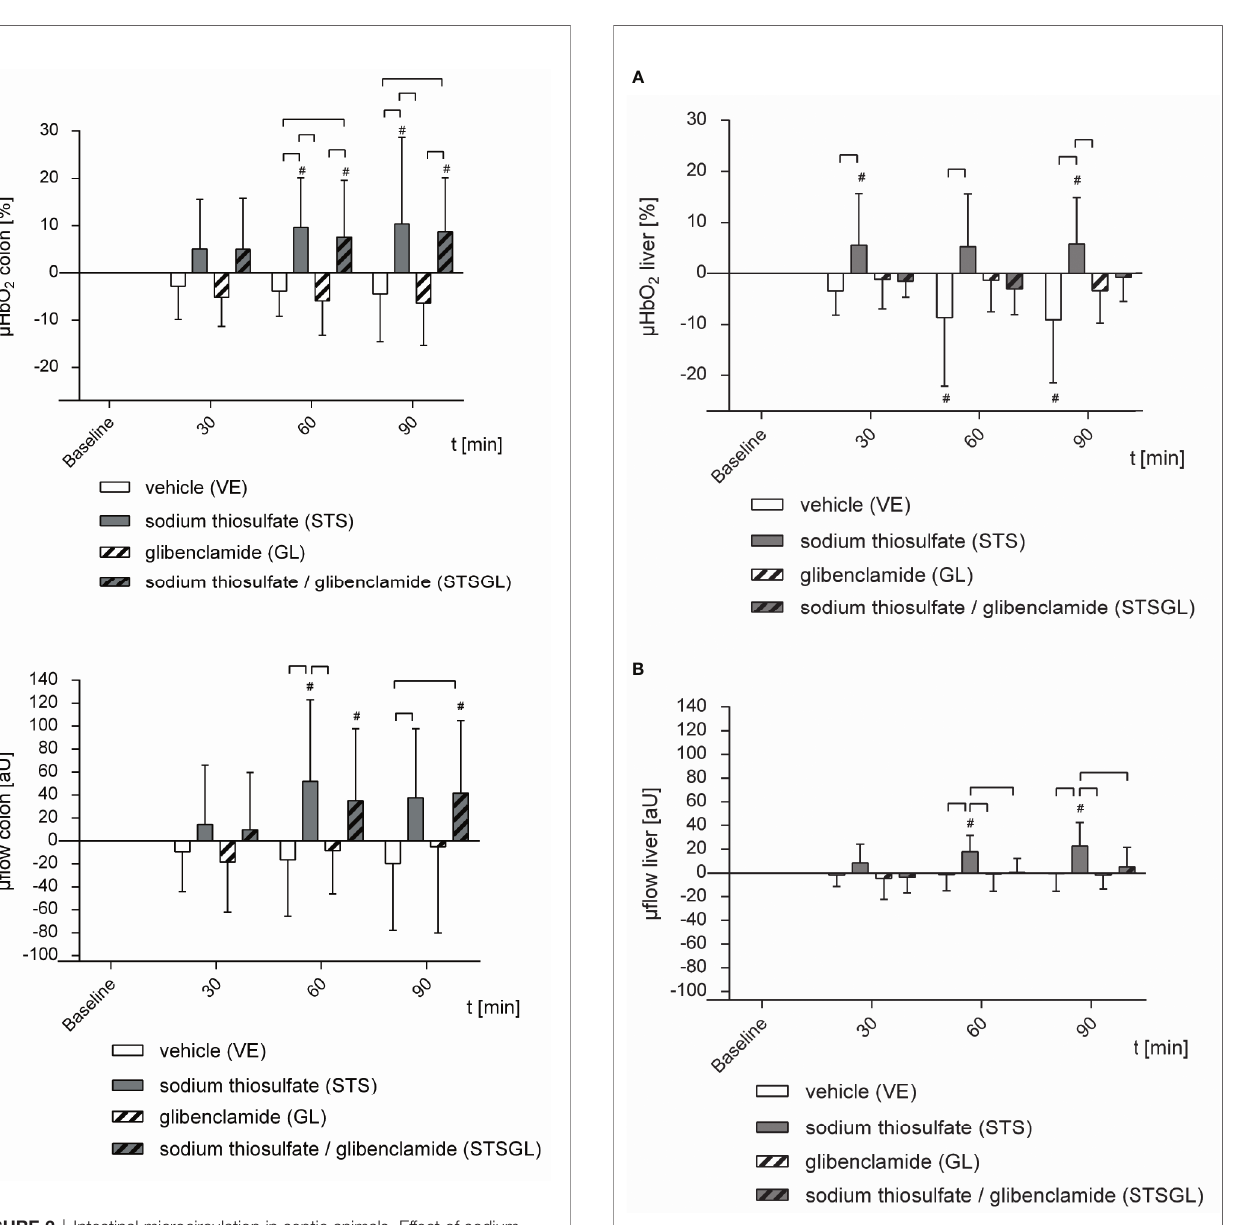
FIGURE 2 | Intestinal microcirculation in septic animals. Effect of sodium thiosulfate (STS), glibenclamide (GL), sodium thiosulfate + glibenclamide (STSGL) or vehicle (VE) on (A) colonic microcirculatory oxygenation (µHBO 2 ) and (B) colonic microcirculatory fl ow (µ fl ow). D µHBO 2 [%] and D µ fl ow [aU] over time calculated to baseline (means ± SD). # = p < 0.05 versus baseline (Two-way ANOVA followed by Dunnett´s post - hoc test) ⎴ between groups (Two-way ANOVA followed by Tukey post – hoc test); n =